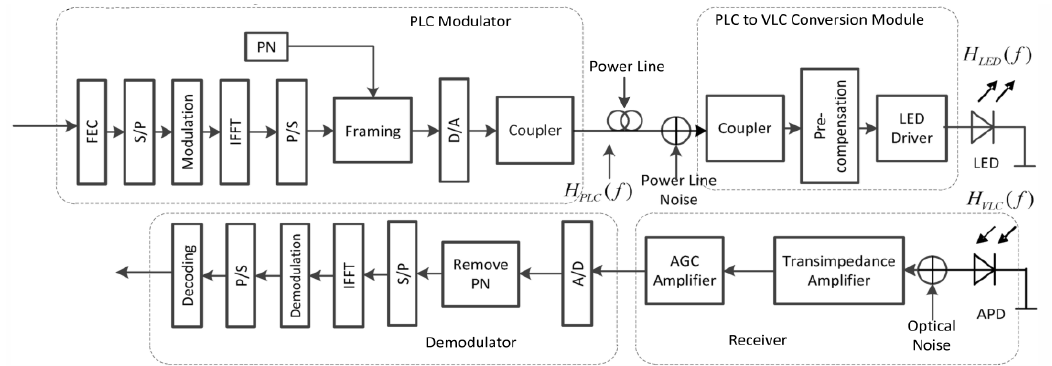
Figure 3. The block diagram of the integrated indoor wireless optical communications-power line communications (IWOC-PLC) system [19].